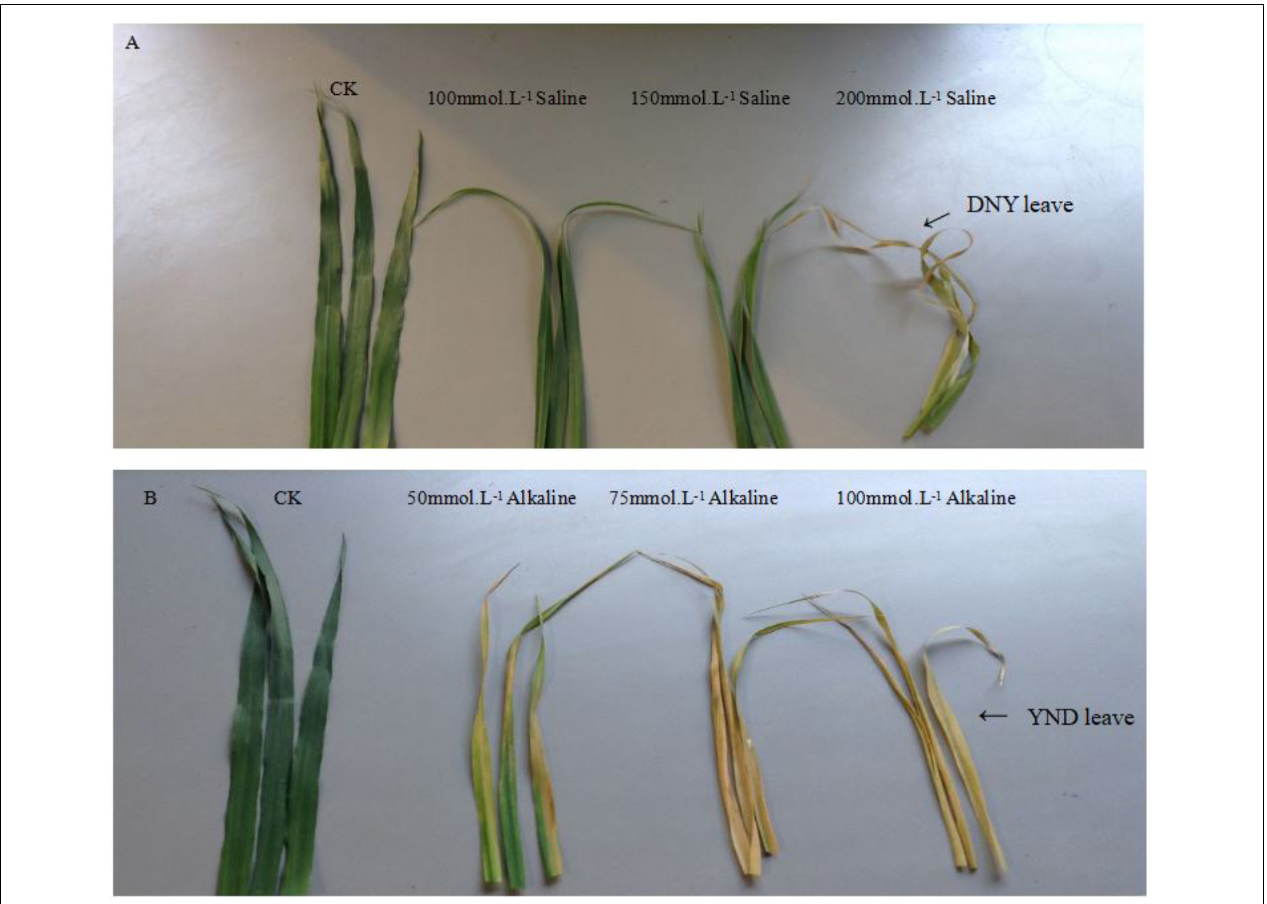
FIGURE 9 | (A) The DNY leaves under salt stress. (B) The YND leaves under alkali stress. DNY leaves = dry but not yellow. YND leaves = yellow but not